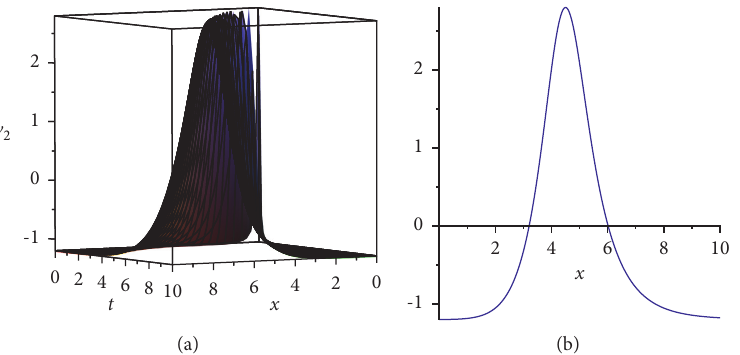
( t,x ) at A � 1 , B � 2, a � 2, α � ( 1/2 ) , β � ( 1/3 ) , k � 2, ξ 2